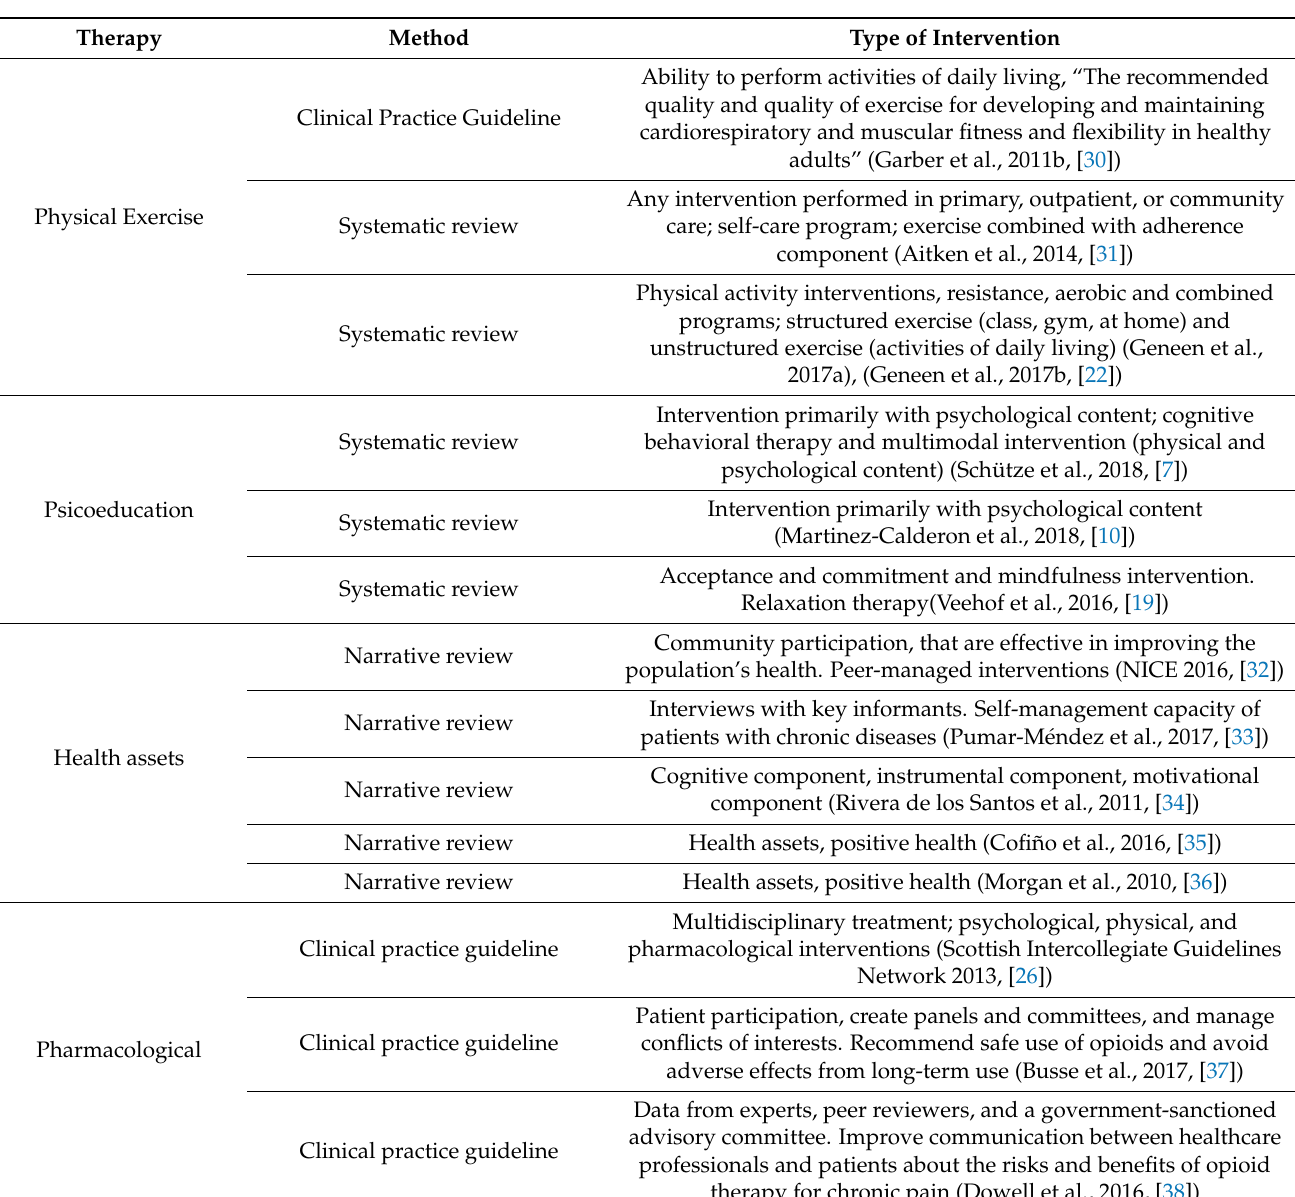
Table 1. Description of Included Studies on Therapy (Method, Type of